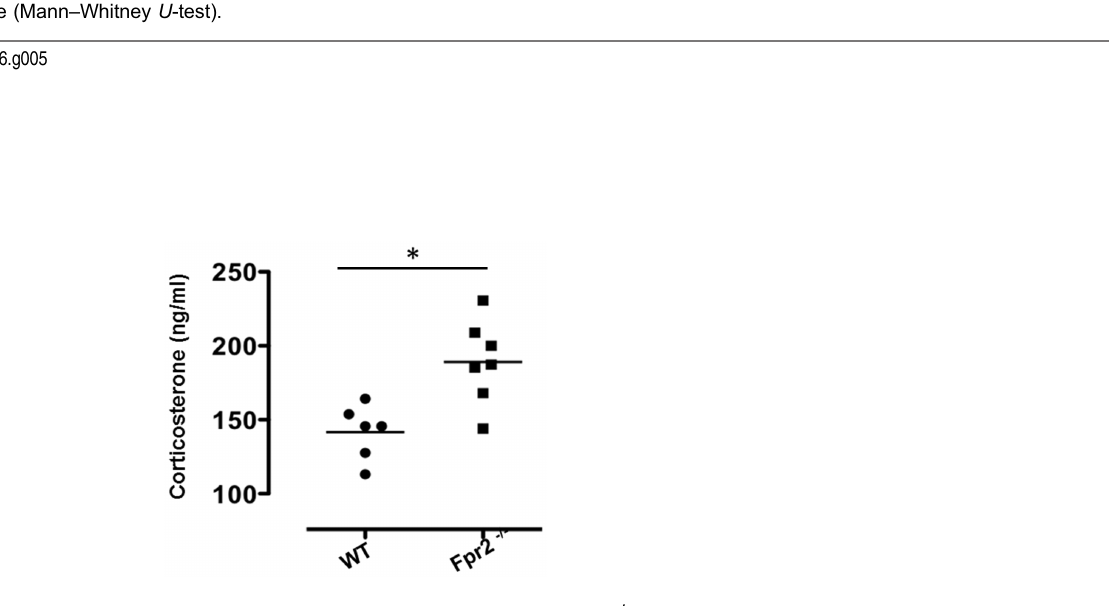
Fig. 6. Increased level of corticosterone in Fpr2/3 -/- mice. Levels of corticosterone in the plasma of WTand Fpr2/3 -/- . Values are expressed as ngml 2 1 and are representative of three experiments with 6